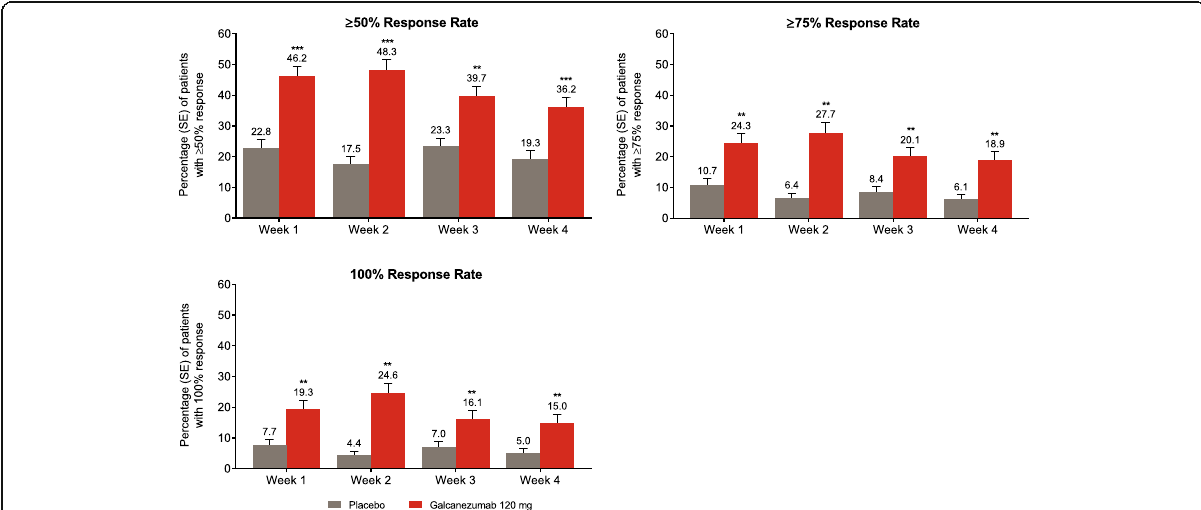
Fig. 5 Estimated mean percentage of patients with ≥ 50%, ≥ 75%, and 100% reduction from baseline in weekly migraine headache days at weeks 1 – 4 of month 1. ** p < 0.01, *** p ≤ 0.0001 vs placebo. SE standard